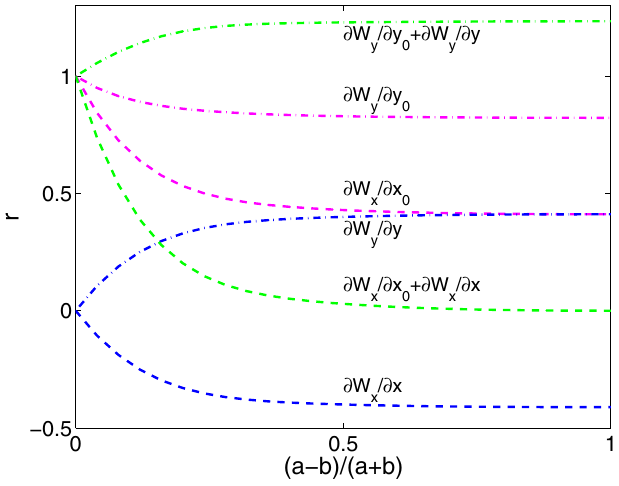
FIG. 4. (Color) r represents the ratio of transverse resistive wall wake potentials for elliptic pipes of horizontal extension 2 a and vertical extension 2 b to those of a round pipe of radius b as at large s (cid:11) s . W denotes the vertical, W function of q (cid:5) a (cid:2) b y x 0 a (cid:6) b the horizontal wake, y the vertical position of the source 0 the particle, y the vertical position of the test particle, x 0 horizontal offset of the source particle, and x the horizontal offset of the test particle. q (cid:5) 0 represents a round pipe, q (cid:5) 1 a flat